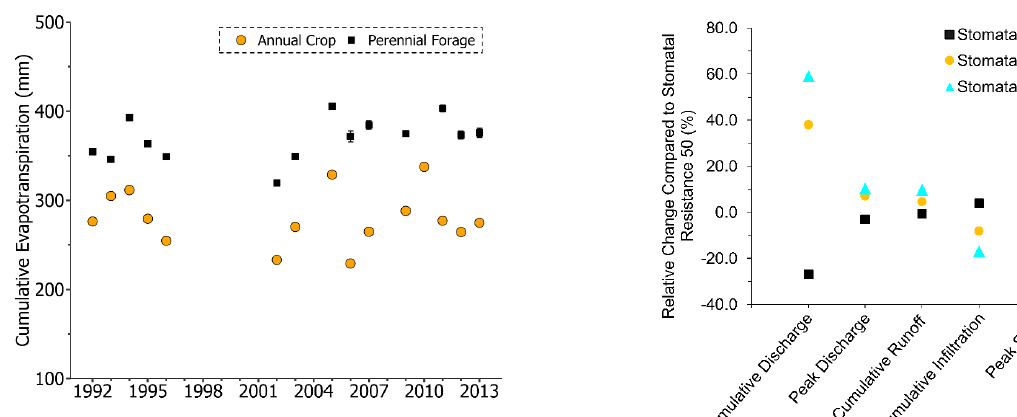
Figure 9. Comparison of annual cumulative evapotranspiration (ET) between annual crop and forage simulations for the La Salle River subbasin (LS-05OG008). The years 1997–2001, 2004, and 2008 were not used for model assessment due to missing data or equipment malfunctions.